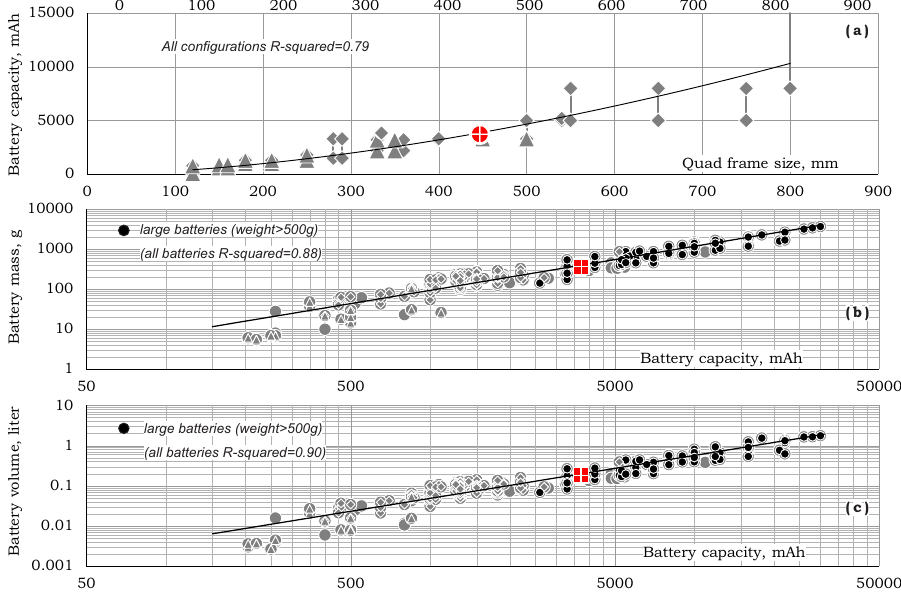
Figure 12. Battery parameters as function of quad frame size and battery capacity, [17,18,23,26,27]. Figure 12a shows a direct relation between battery capacity and the quad frame size that may be expressed